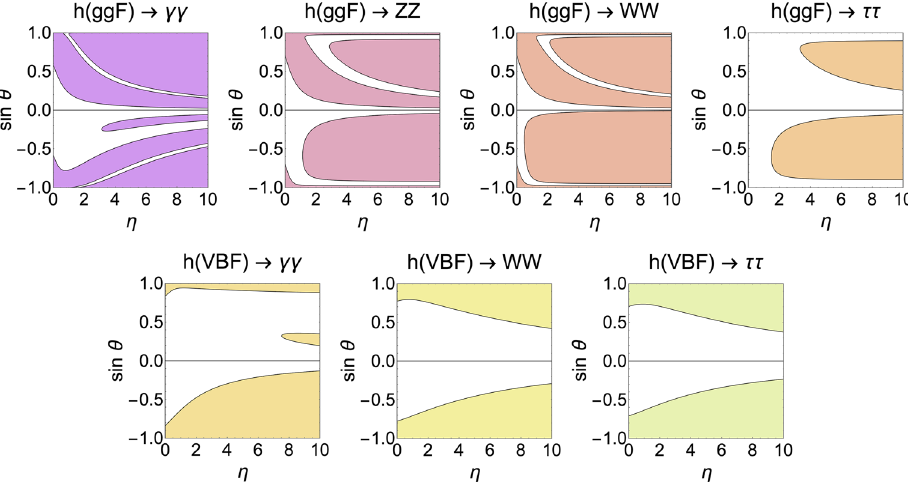
Fig. 5 The 2 σ -excluded regions from the signal strength of 125GeV Higgs. The top-partner parameters are chosen as an illustration to present the contribution from each